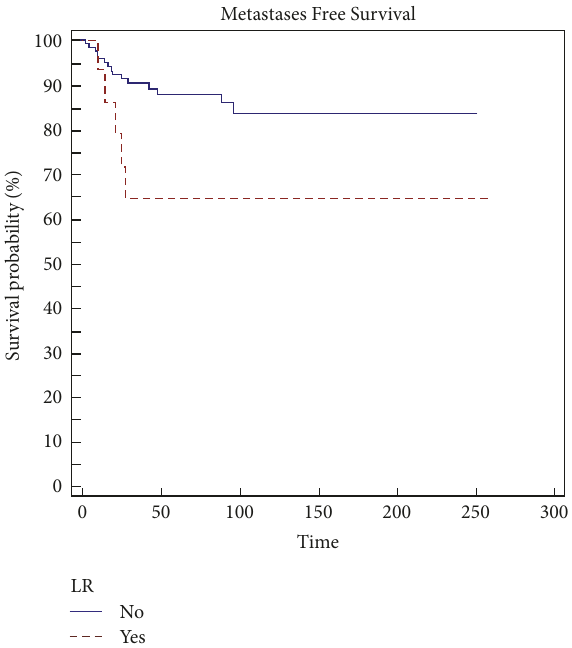
Figure 5: Local recurrence is a significant risk factor ( 𝑝 = 0,0437) in metastasis-free survival (MFS).